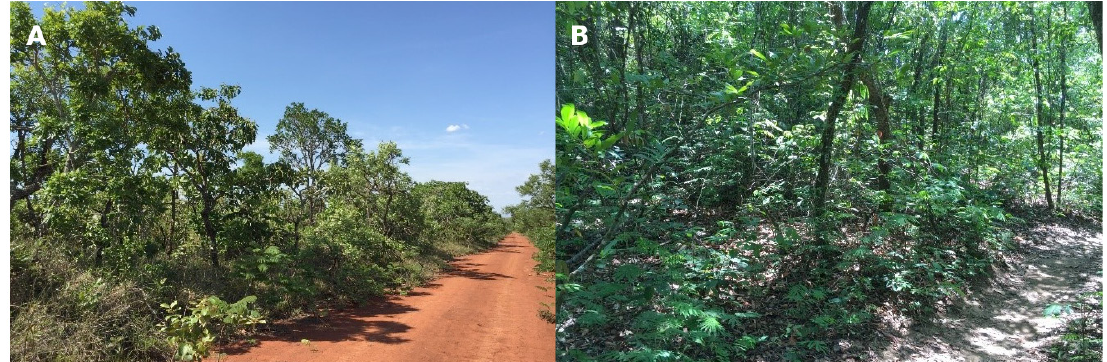
Fig 1. Characterization of the study areas. Cerrado stricto sensu (A) and cerradão (B) in PESCAN, Caldas Novas, Goiás,